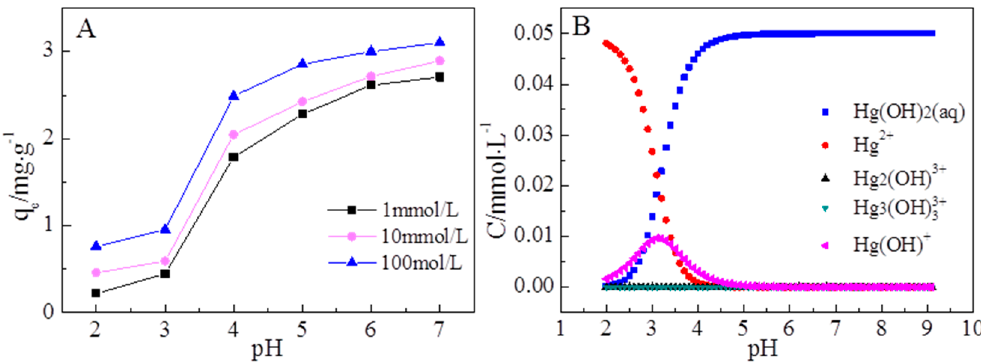
Figure 2. ( A )The effect of pH and ionic strength. ( B ) Distribution of Hg(II) in water solutions ( C 0 = 10 mg/L, I = 0.01 mol/L, T = 303 K).